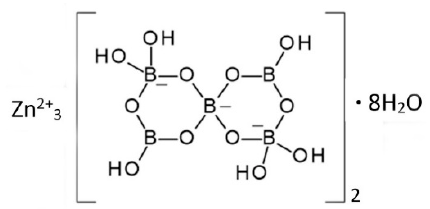
Figure 5. The proposed structure of 3ZnO ∙ 5B 2 O 3 ∙ 14H 2 O [17].